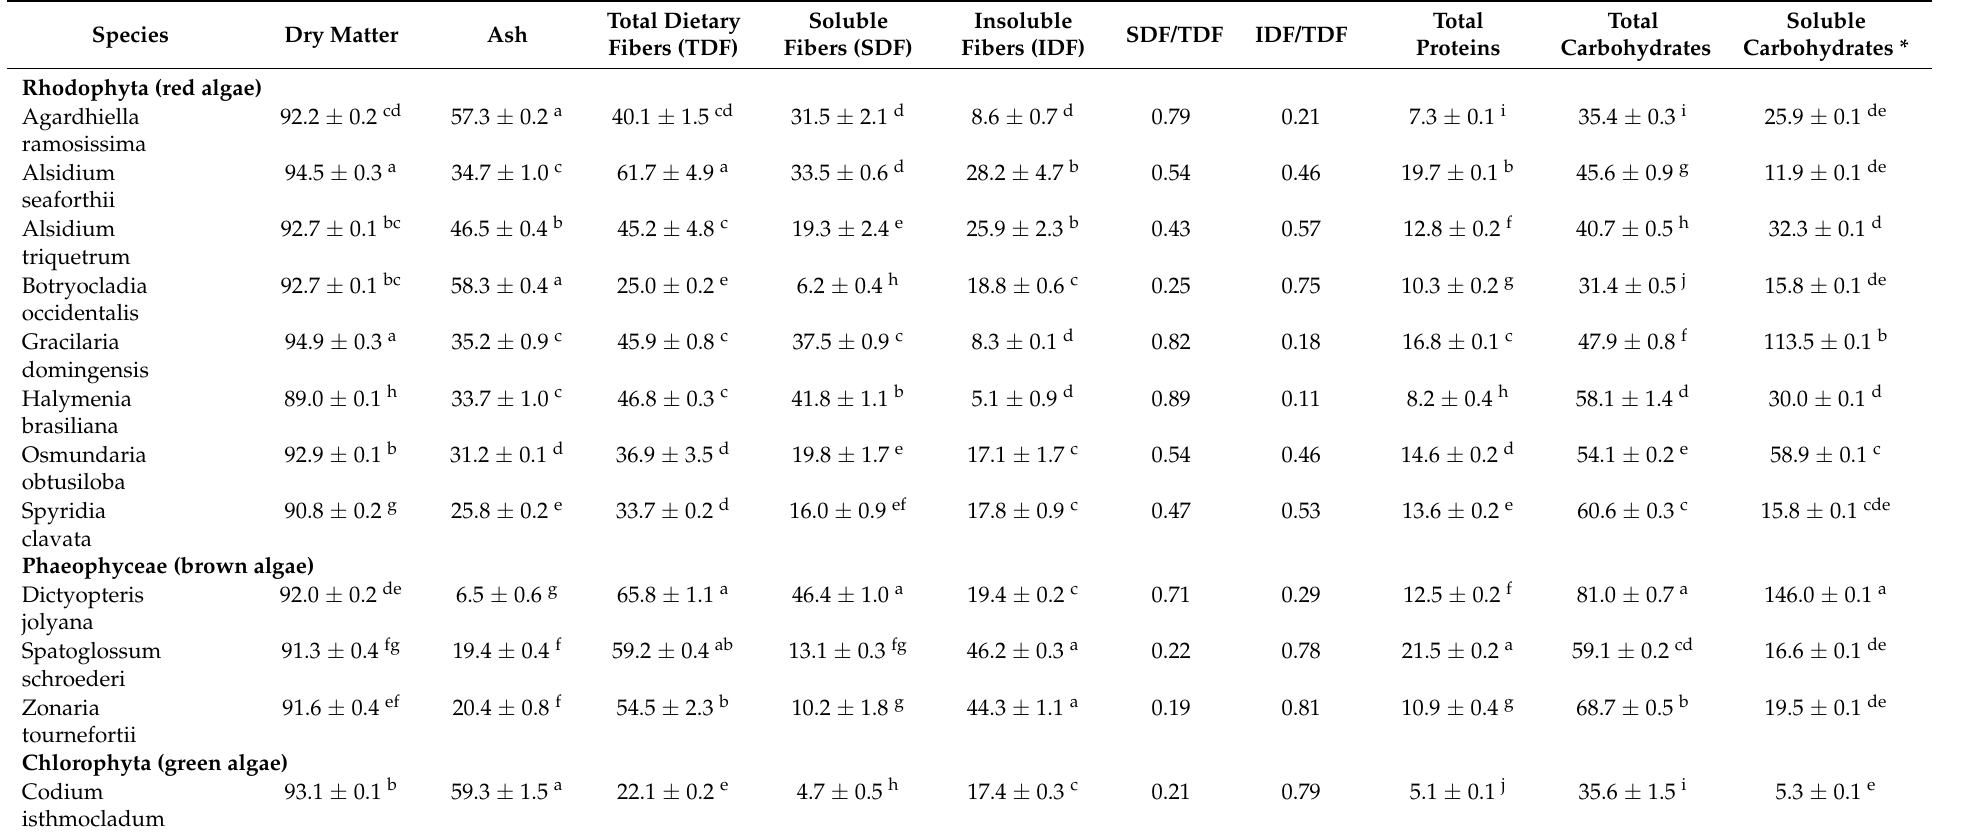
Table 1. Proximate composition of beach-cast macroalgae (g/100 g = % and * µ g galactose/mg on dry mass basis). Values represent the average of three replicates (mean ± SD), and letters indicate statistical significance ( p < 0.05). Total carbohydrates calculated by difference = 100-total